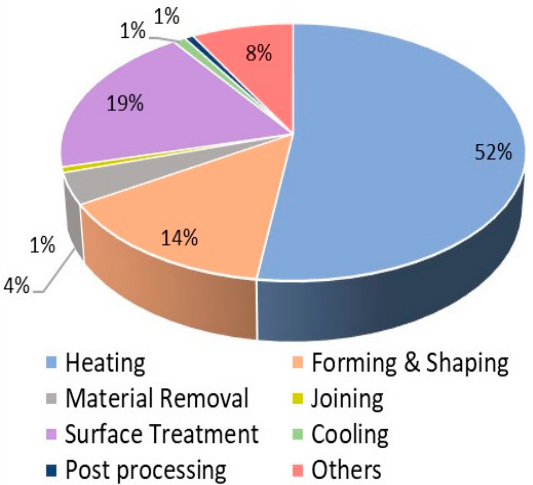
Figure 16. The share of CO 2 emissions for the production unit processes in the Swedish engineering industry (Scenario 1).